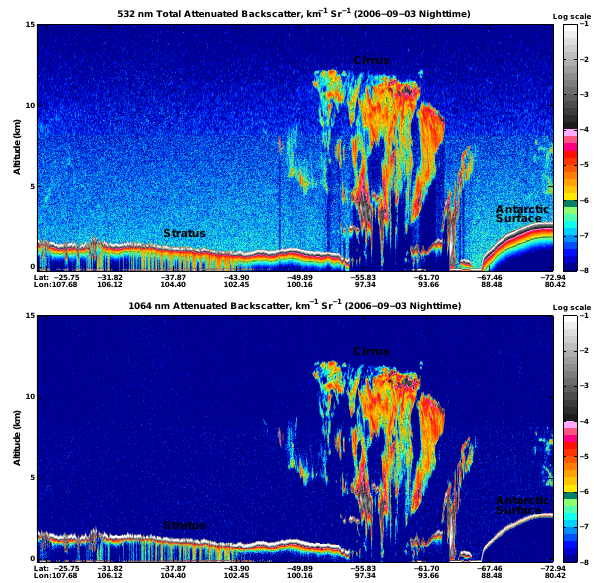
Fig. 1. CALIPSO data images of 532 nm (top panel) and 1064 nm (bottom panel) total attenuated backscatter.